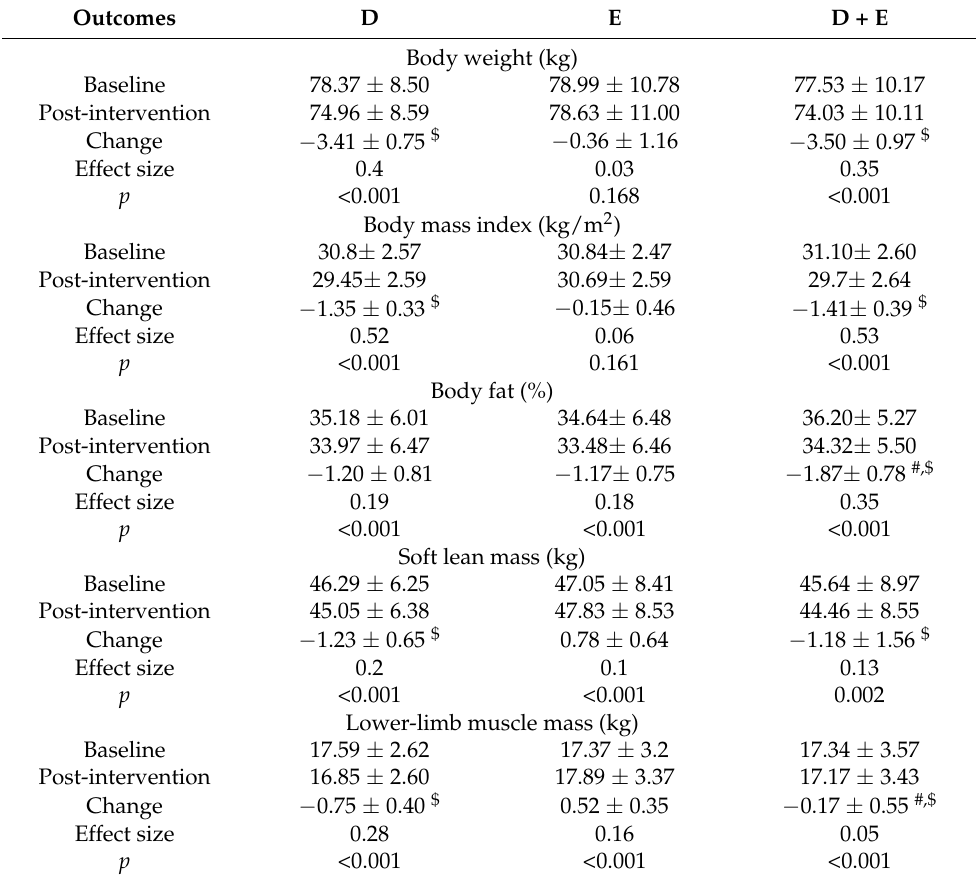
Table 2. Improvements in body composition after the 12-week